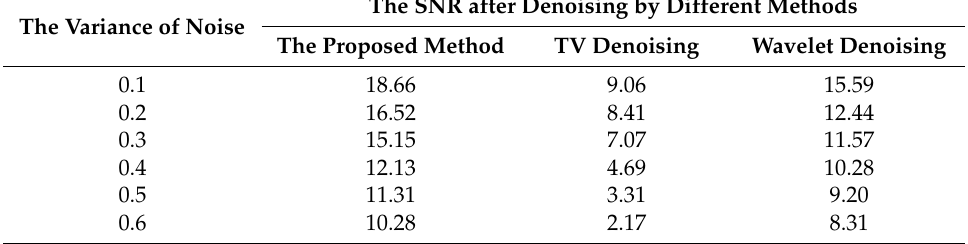
Table 1. The performance of different denoising methods. SNR: signal ‐ to ‐ noise ratio; TV: total variation.